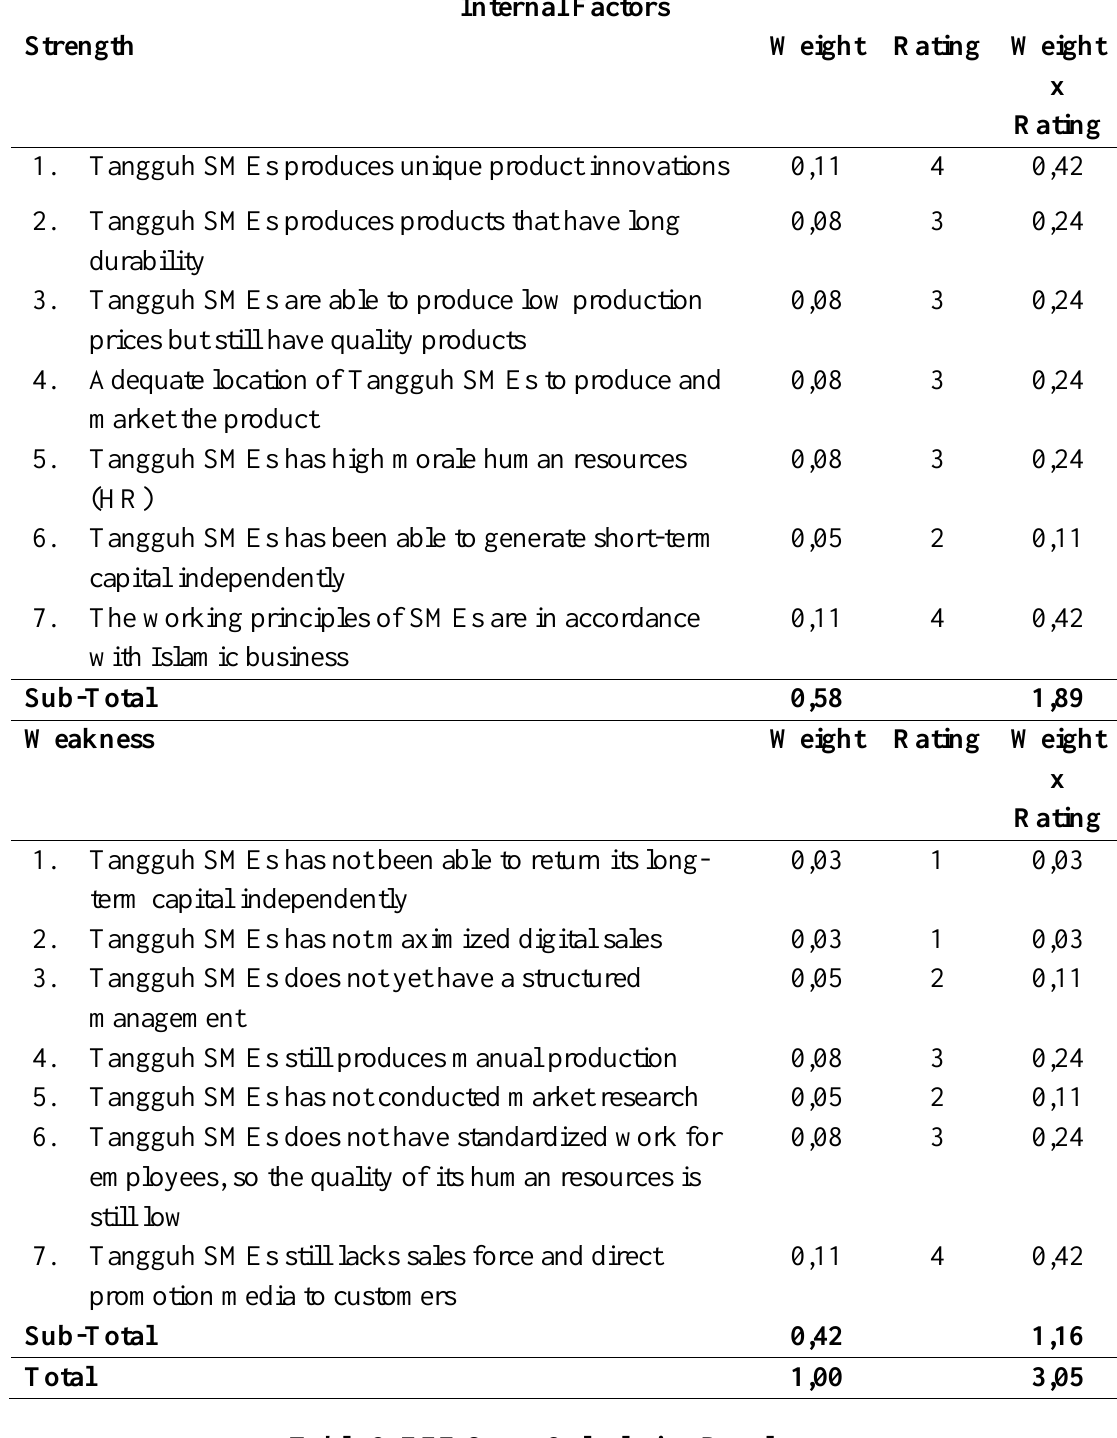
Table 2. EFE Score Calculation